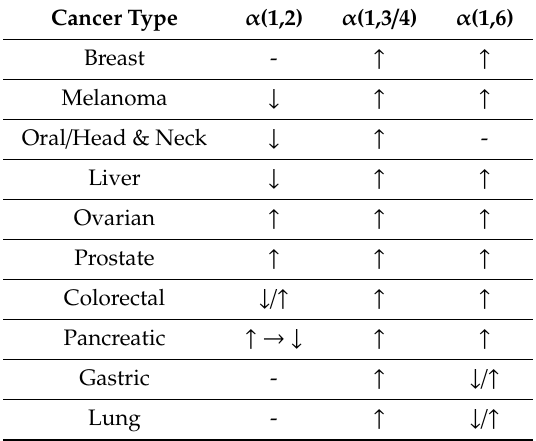
Table 8. Visual summary of fucosylation changes of the branching types in cancer tissues vs. normal tissues. ↑ -increased; ↓ -decreased; ↑→↓ -increased in primary, decreased in metastasis. Cancer